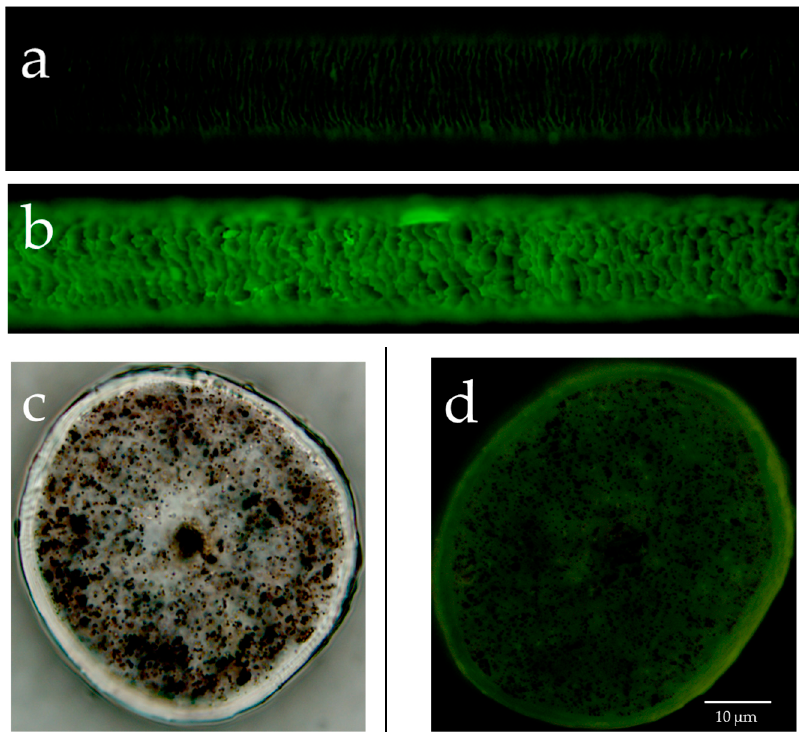
Figure 2. Fluorescence microscope images of fluorescence due to hydroxy radicals in human hair exposed to UV radiation and not exposed to UV radiation. Fluorescence microscope image of hydroxy radicals on the surface of hair not exposed to UV radiation ( a ), fluorescence microscope image of hydroxy radicals on the surface of hair exposed to UV radiation ( b ). Images of the cross-section of hair exposed to UV radiation. A bright-field view image of the cross-section of hair exposed to UV radiation ( c ), fluorescence microscope image of hydroxy radicals in the cross-section of hair exposed to UV radiation ( d ).